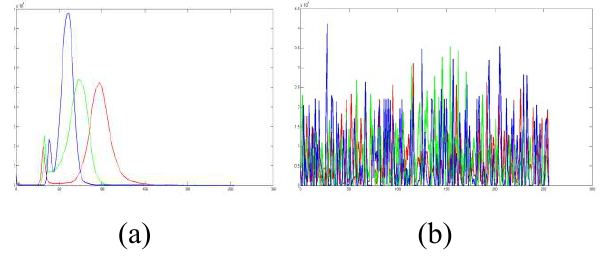
Fig. 6 . Histogram Analysis (a) Original Raster Data (Sat_Image1), and (b ) Encrypted watermarked Raster